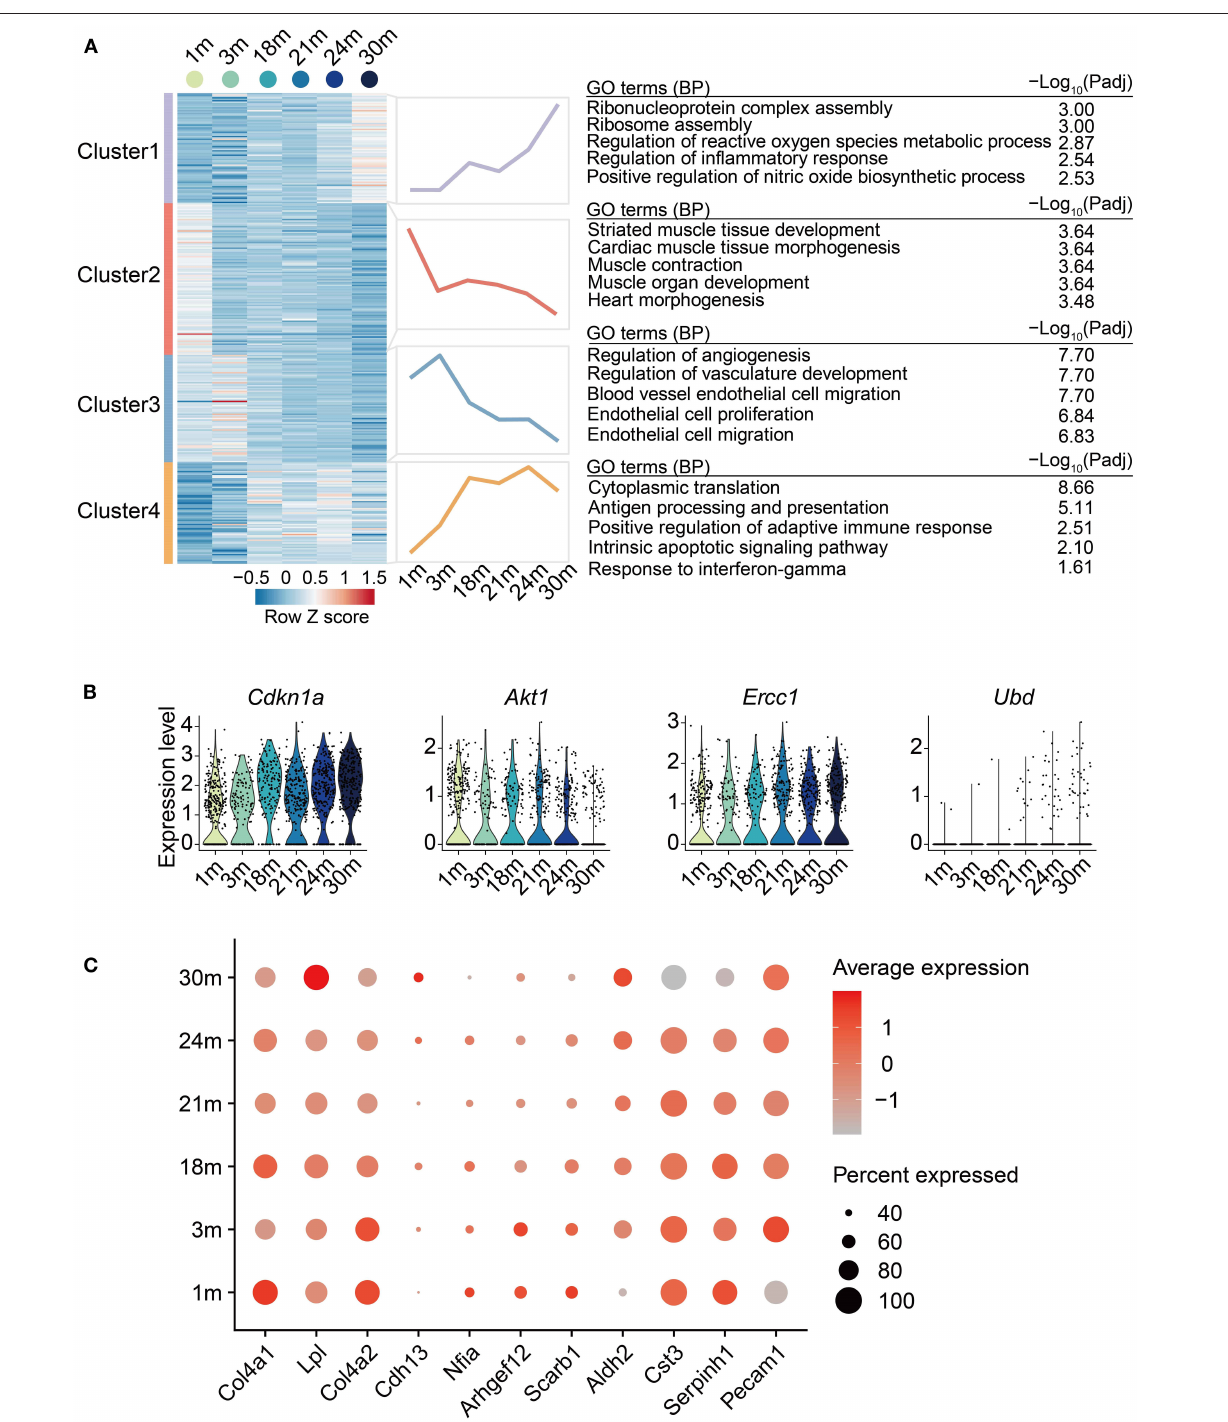
Frontiers in Cardiovascular Medicine |